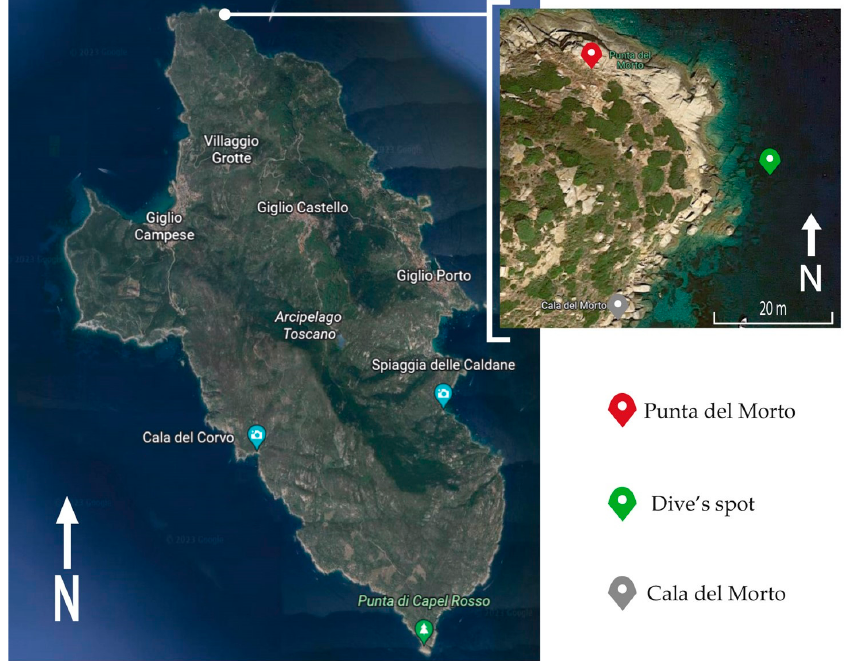
Figure 1. Map of the Giglio Island with the diving spot at Punta del Morto (map of the Giglio Island modified from Google Earth ; aerial image by Google Maps) [20].